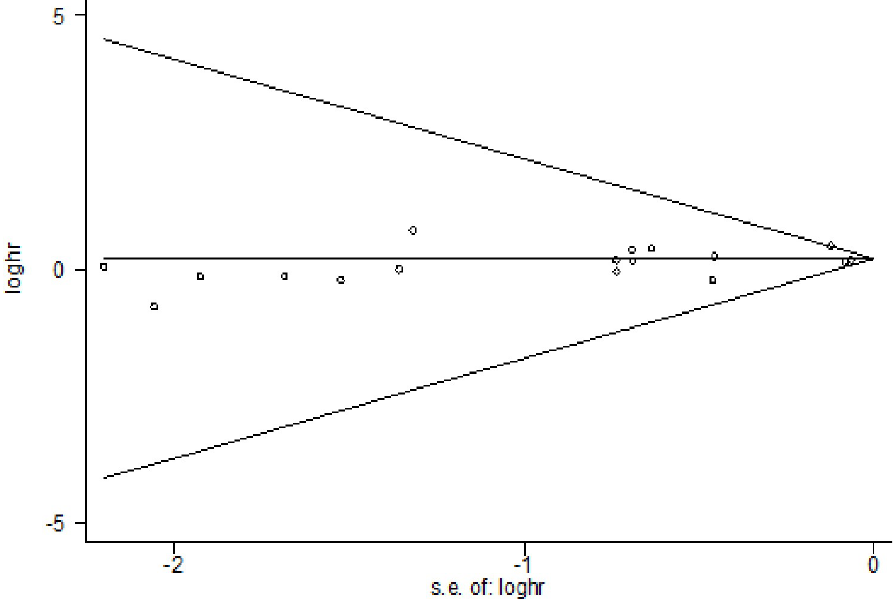
Fig 4. Funnel plot of traumatic brain injury and the risk for